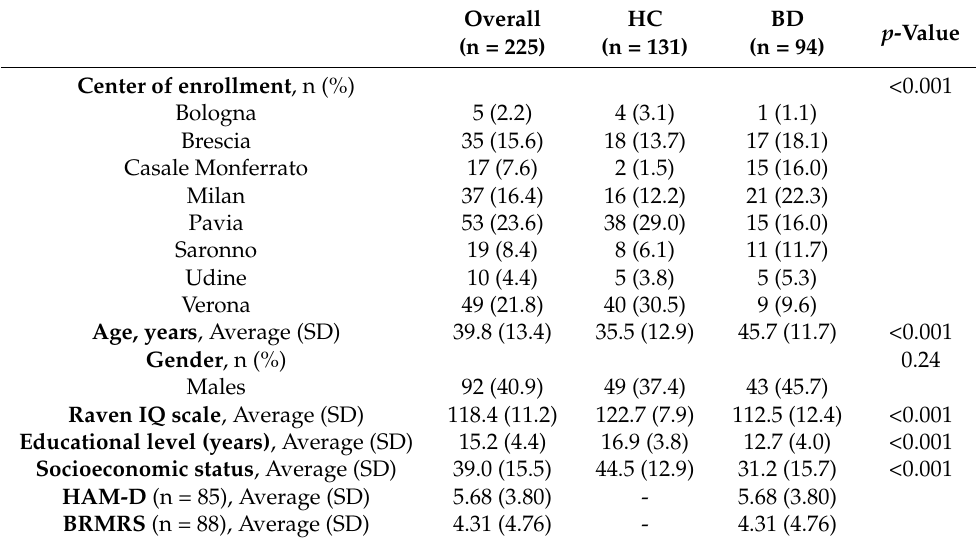
Overall HC (n = 225) (n = 131)